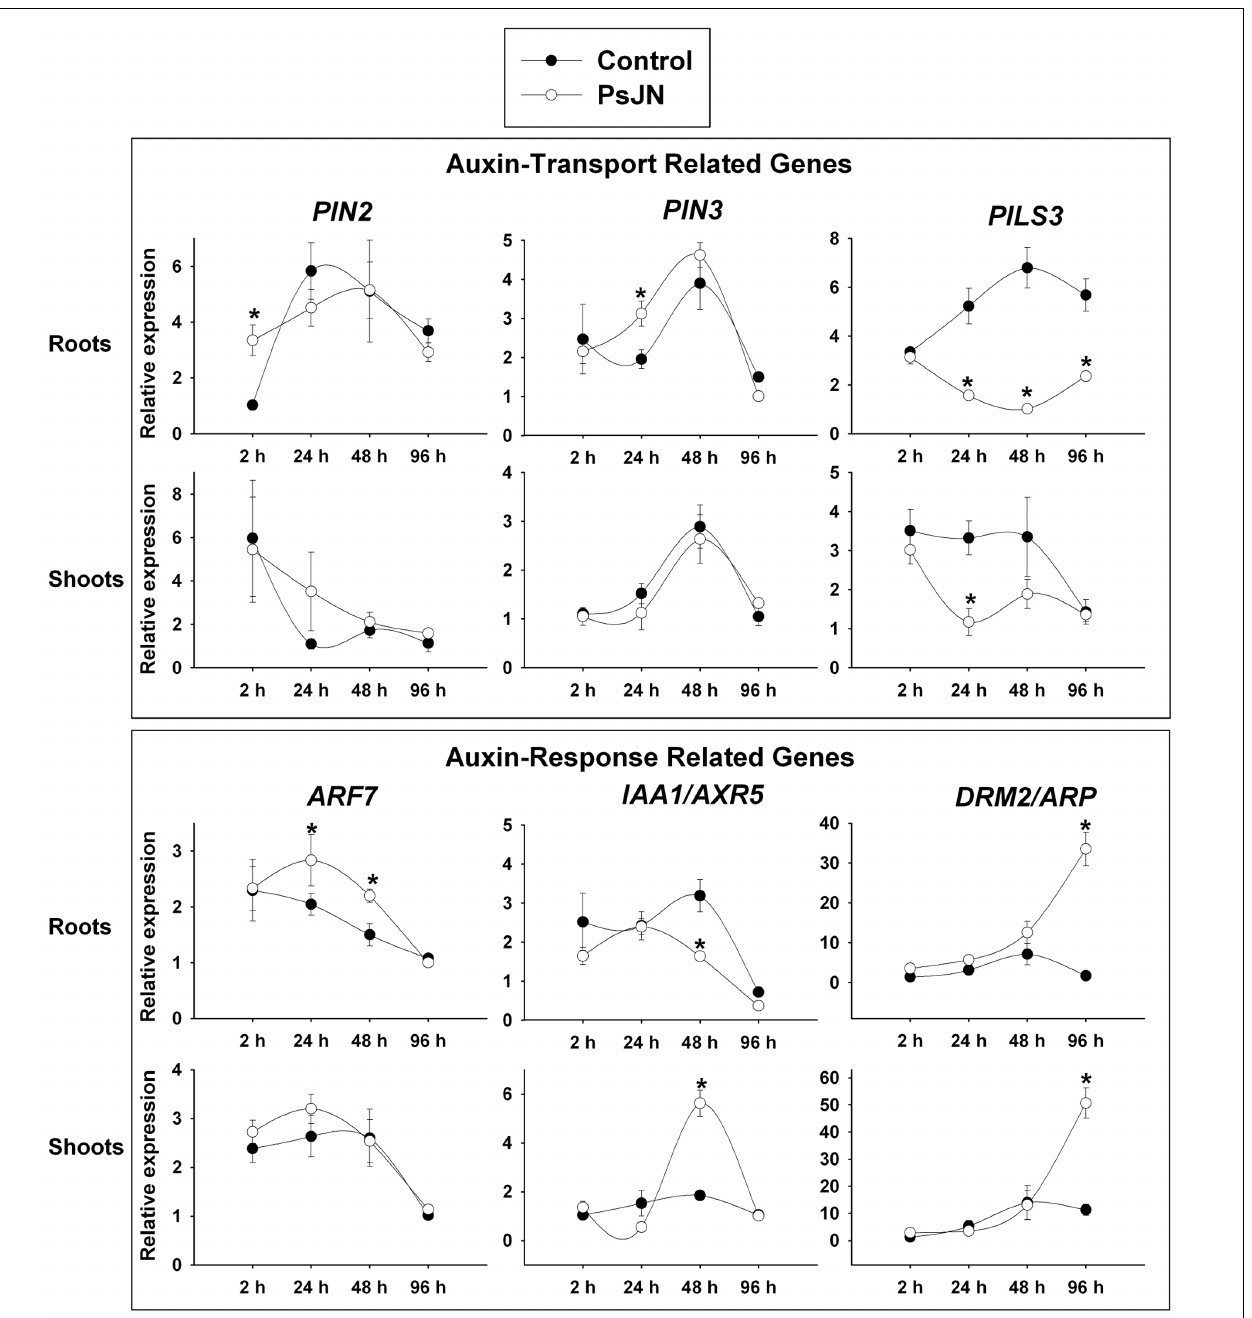
FIGURE 2 | Temporal quantitative real-time PCR of selected Arabidopsis genes involved in auxin transport and response after inoculation with B. phytofirmans PsJN. Relative gene expression of selected genes involved auxin transport and response in roots and shoots at 2, 24, 48, and 96 hpi with the strain. Data are means ± SE of 3–5 biological replicates per treatment, each considering tissue from 5 to 13 plants and two technical replicates. Normalization was performed with the housekeeping SAND family gene (AT2G28390). Asterisk indicates statistical significance among treatments in a particular time (One way ANOVA, p <